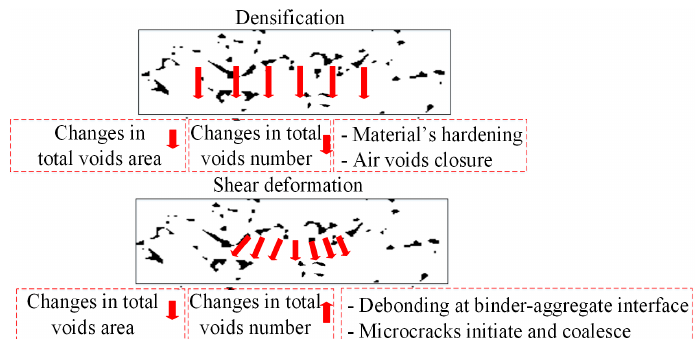
Figure 15. Correlation between damage mechanisms and changes in air-void content properties.